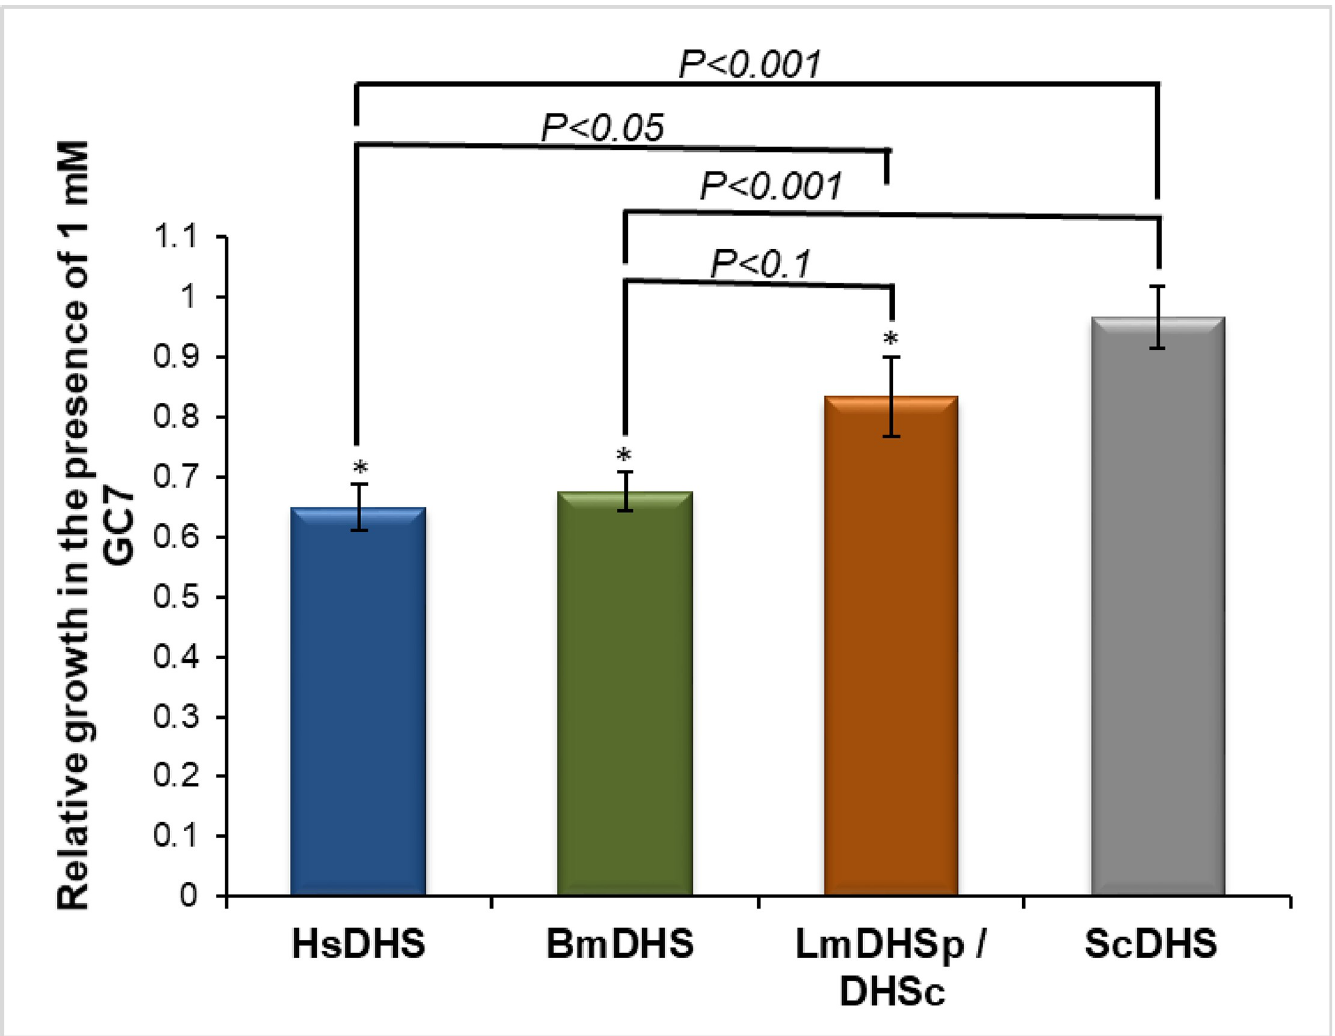
Fig 7. Yeast-based assay can detect DHS inhibitors. Bars show the relative growth score of dys1 Δ S . cerevisiae strains complemented by the indicated DHS enzymes and the relative growth score of the wild type and isogenic strain VZL1462 (ScDHS—Table 2) in the presence of 1 mM GC7. A single star ( � ) indicate statistically significant differences (Student’s t-test p < 0.05) between the growth score of individual strains in the presence or absence of